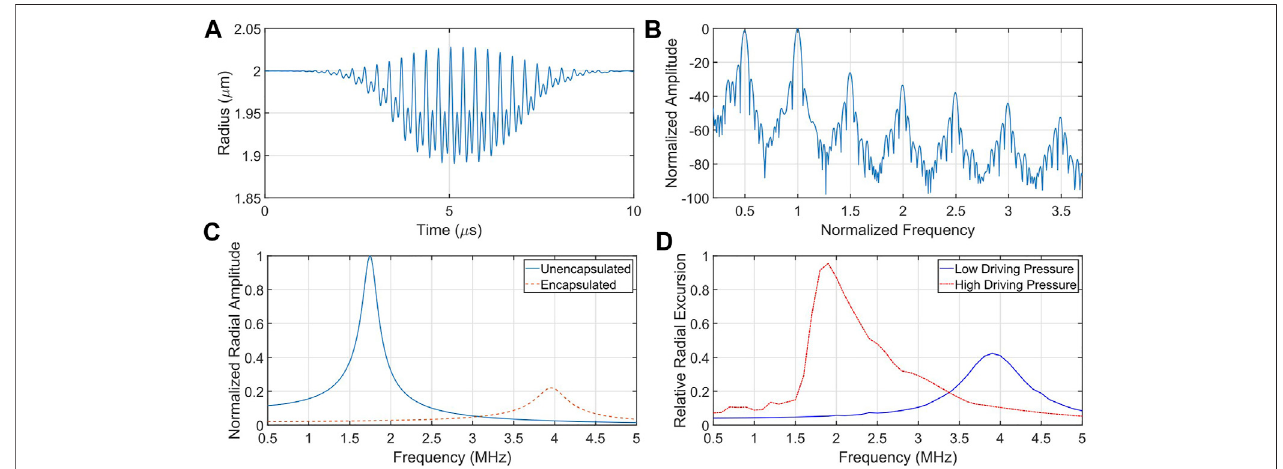
FIGURE 1 | Illustrative microbubble simulations depicting its resonant and nonlinear behaviour. (A) Radius versus time of an oscillating microbubble and (B) it is correspondingfrequencycontent.Notethepresenceofsubharmonic(0.5),ultraharmonic(1.5,2.5,3.5)andharmonic(2,3)energy,aswellasenergyatthefundamental frequency band (1). (C) The presence of an encapsulating shell serves to increase the resonance frequency and dampen the vibrational amplitude of an otherwise identical microbubble. (D) Under large forcing conditions, microbubbles exhibit asymmetrical resonance, including a shift down in resonance frequency with increasing forcing amplitude. Note here the inherent skewing of the resonance response, typical of a strain-softening resonator.